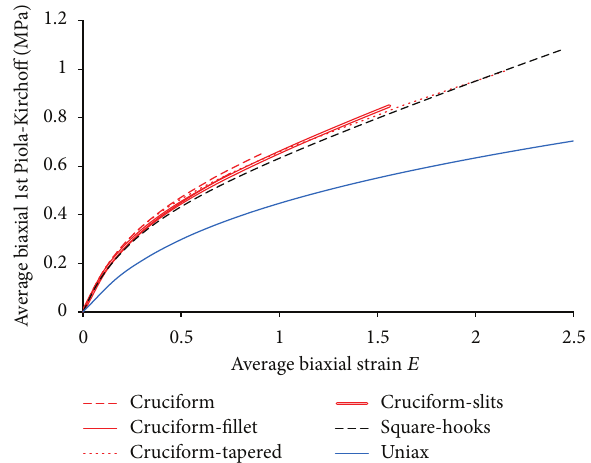
Figure 6: Stress-strain curves computed with finite element simu- lations.